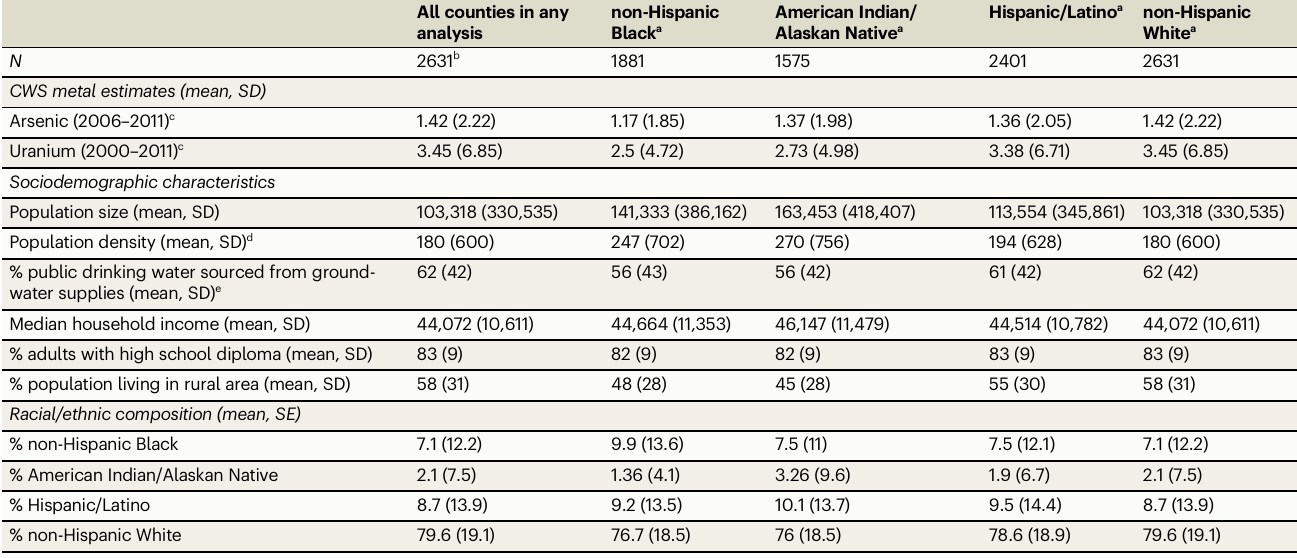
Table 1 | County-level mean estimated community water system (CWS) metal concentrations and sociodemographic char- acteristics for all counties included in any analysis ( N = 2631 counties), and separately for counties included in analyses speci fi c to each racial/ethnic group (counties with >100 residents of each racial/ethnic group) All counties in any non-Hispanic analysis Black